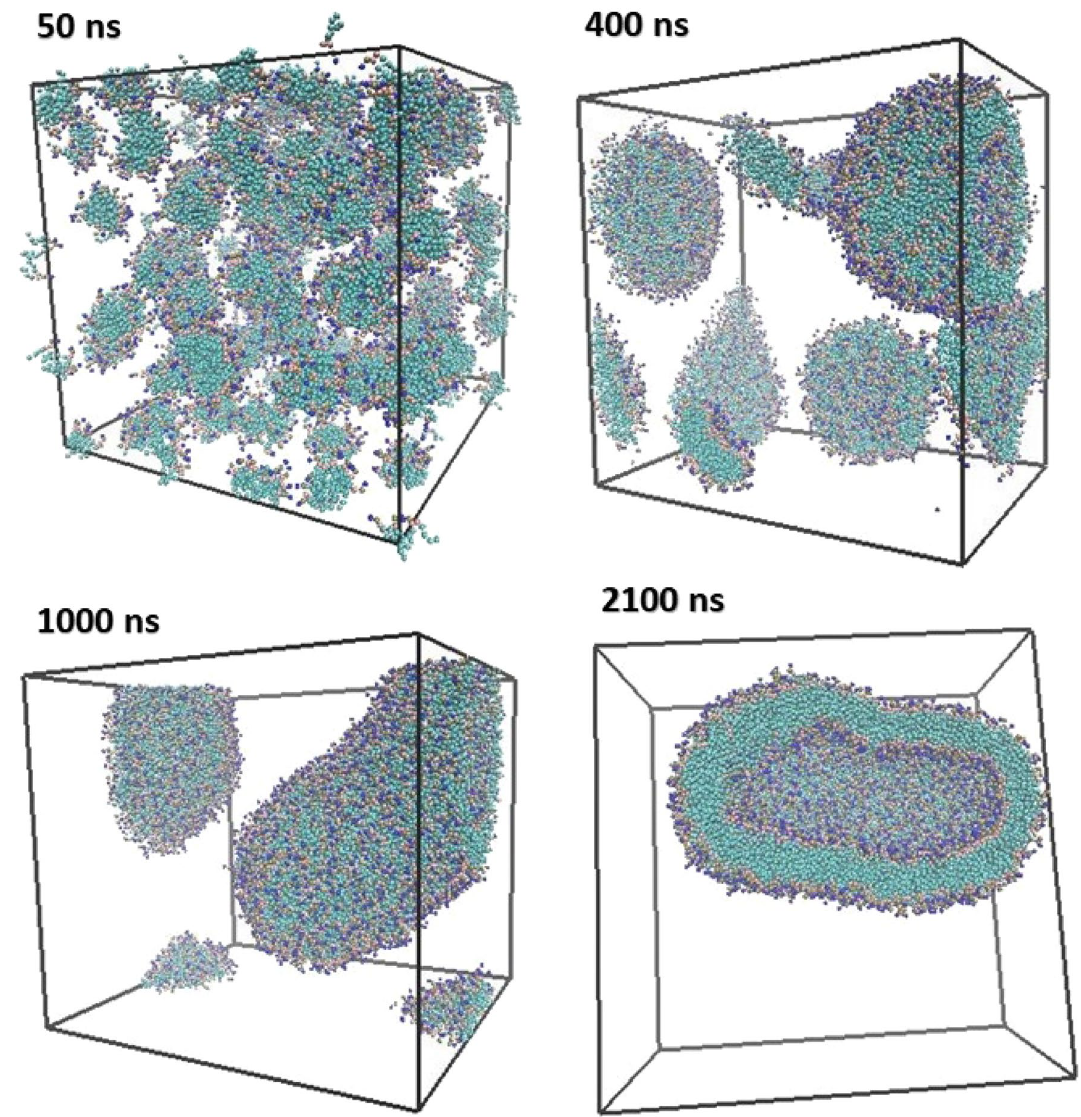
Figure 4. Snapshots of the formation steps of the coarse-grained structure of vesicle from the DOPC and DOPE phospholipids were shown. In the 400 ns and subsequent snapshots, phospholipid particles form a pre-structure of the vesicle. The pre-structure of the vesicle gradually becomes larger with the collision and assembly of phospholipid packs. The times reported that simulation times and water particles were omitted in all snapshots for enhancement of precision. The box is a cubic type with a dimension of 20 nm. Figures are rendered by